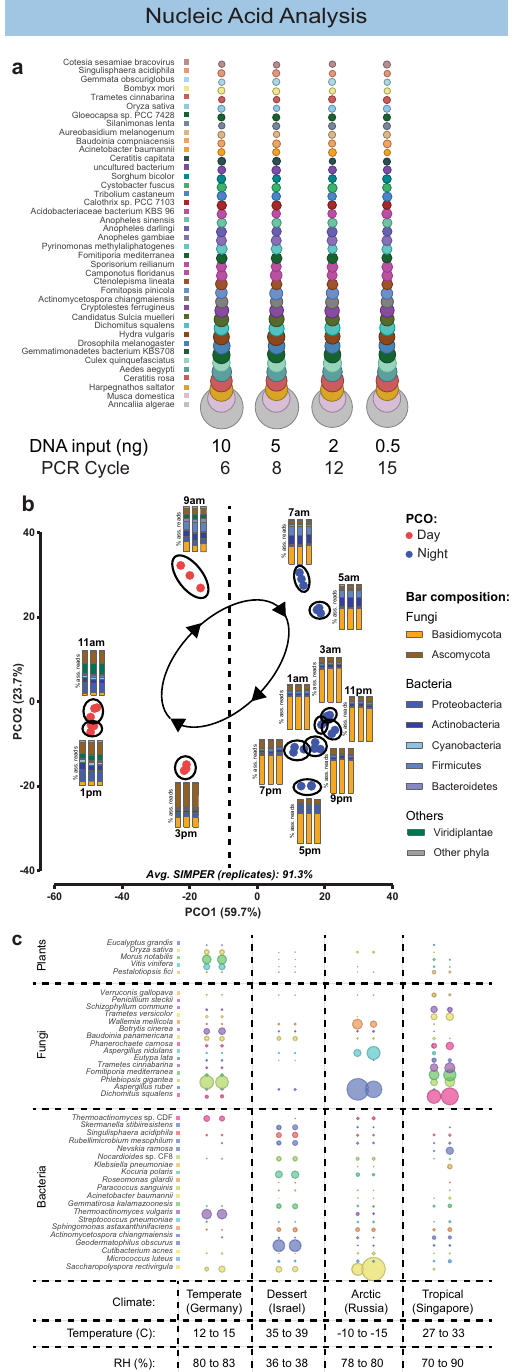
Fig. 5 Whole genome shotgun (WGS) sequencing of air samples. a Comparison of taxonomic pro fi le at species level for the same air sample that was subjected to WGS sequencing with different DNA input amounts (10 – 0.5 ng). b Reproducibility of samples collected at the same time and location (triplicates) illustrated in principal coordinate analysis (Bray – Curtis) at species level. The bars show the microbial community composition of the triplicates in % of assigned reads. c Robustness of air sampling and processing pipeline tested at locations with temperate, dessert, sub-arctic and tropical